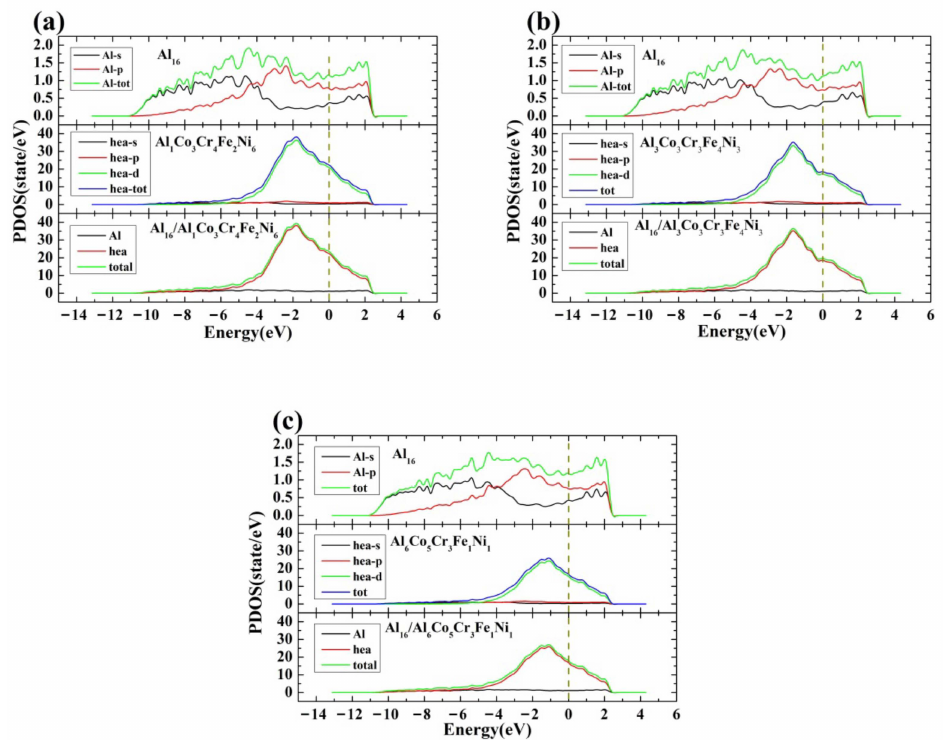
Figure 5. The computed layer-projected densities of states for the interfacial regions with three different Al (or Ni) concentrations, ( a ) Al 16 /Al 1 Co 3 Cr 4 Fe 2 Ni 6 , ( b ) Al 16 /Al 3 Co 3 Cr 3 Fe 4 Ni 3 , ( c ) Al 16 /Al 6 Co 5 Cr 3 Fe 1 Ni 1 ; the dashed line refers to the Fermi